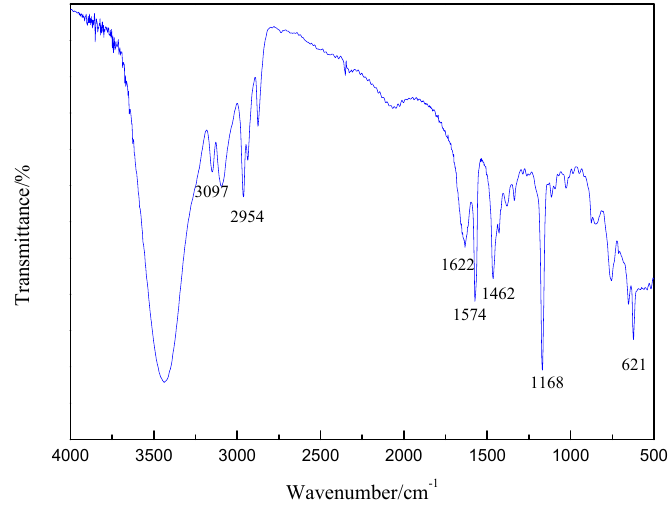
Figure 2. FTIR of di-[EMIM]Cl ionic liquid.